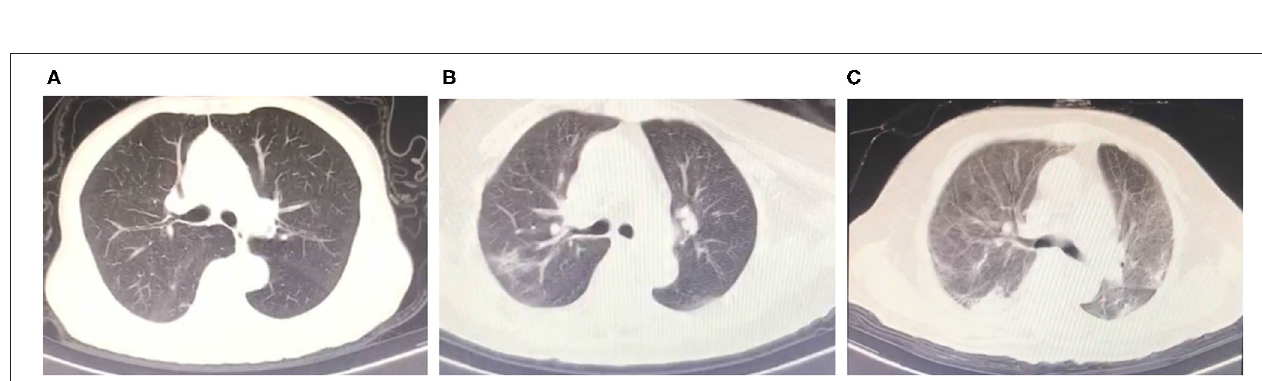
FIGURE 5 | Chest CT scans and CEA levels of three female patients. (A) Four points CT scores and 0.9ng/ml CEA levels. (70 years old). (B) Sixteen points CT scores and 3.1ng/ml CEA levels (70 years old). (C) Twenty two points CT scores and 7.7ng/ml CEA levels (69 years old).